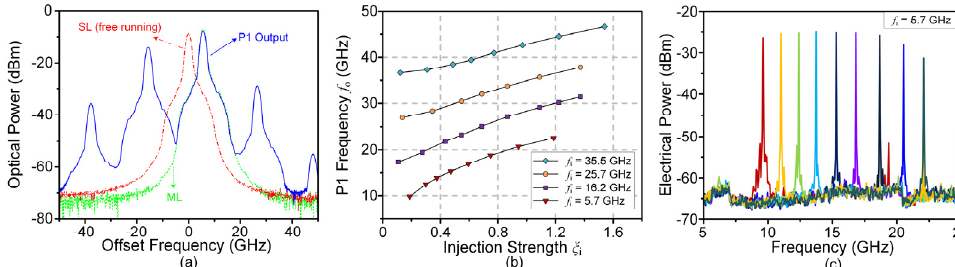
Figure 4. ( a ) Optical spectra of the injection light (green), the free-running SL (red), and the injected SL (blue) when ( f i , ξ i ) equals (5.7 GHz, 0.84); ( b ) P1 frequency f o as a function of the injection strength ξ i for different detuning frequencies f i ; ( c ) electrical spectra when f i = 5.7 GHz.